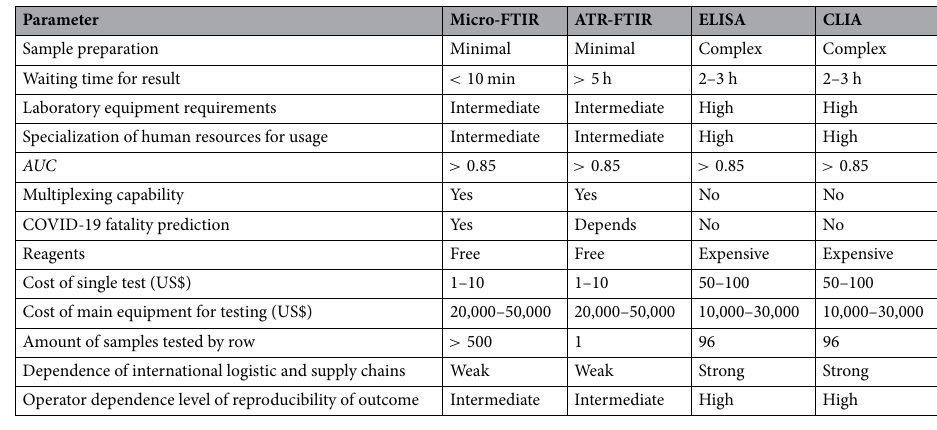
Table 3. Parameters for maintenance, management, operating, and performance of the main anti-Sars-Cov-2 clinical tests ELISA and CLIA compared to the ATR-FTIR and